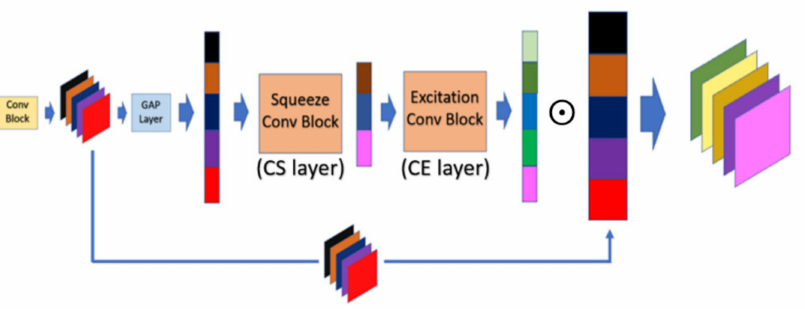
Figure 4. Operation mechanism architecture of channel attention module